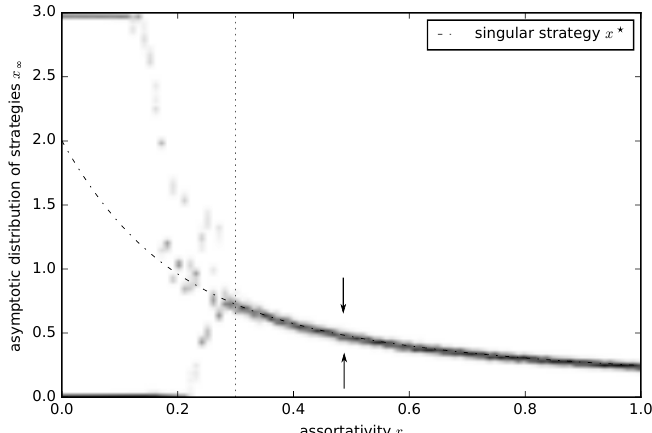
Figure 10. Variation of the distribution of asymptotic strategy values x ∞ with assortativity r , in a continuous tragedy of the commons (CTOC) game with quadratic cost and cubic benefit functions: C ( x ) = x 2 and B ( x ) = − 0.0834 x 3 + 2 x 2 + x . Parameters: n = 10,000, x 0 = 0.1, x m = 3, µ = 0.01, σ = 0.005, and β = 1. Arrows indicate the direction of evolutionary